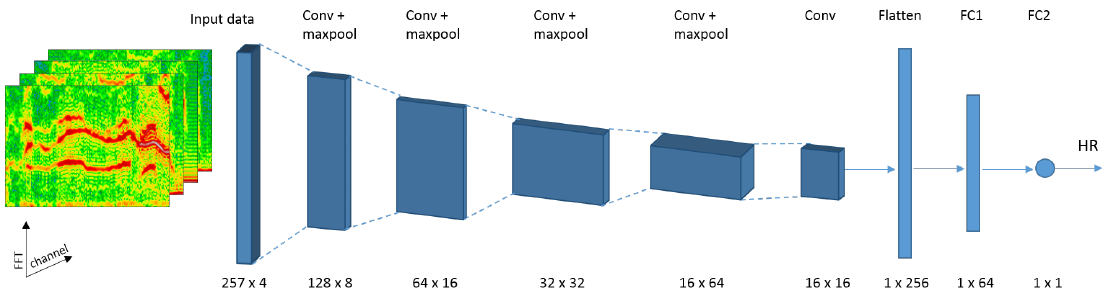
Figure 9. Proposed resource-constrained CNN-model. Input: 257 × 4 matrix (time-frequency spectra of the PPG-signal and three acceleration channels). Output: heart rate